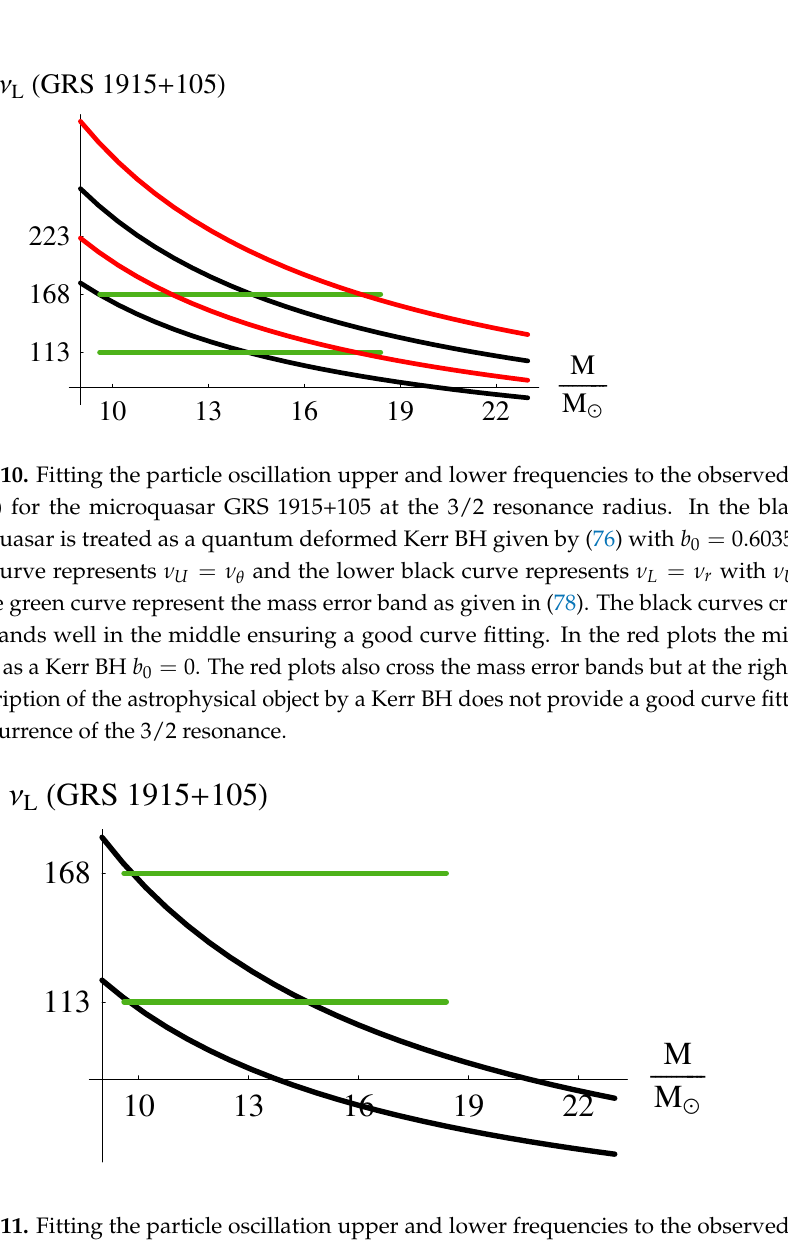
Figure 11. Fitting the particle oscillation upper and lower frequencies to the observed frequencies (in Hz) for the microquasar GRS 1915+105 at the 3/2 resonance radius. In the black plots the microquasar is treated as a quantum deformed Kerr BH given by (76) with b 0 = 1.2149, which is an upper limit for b 0 . The upper black curve represents ν U = ν θ and the lower black curve represents ν L = ν r with ν U / ν L = 3/2, and the green curve represent the mass error band as given in (78). The black curves cross the mass error bands at the leftmost